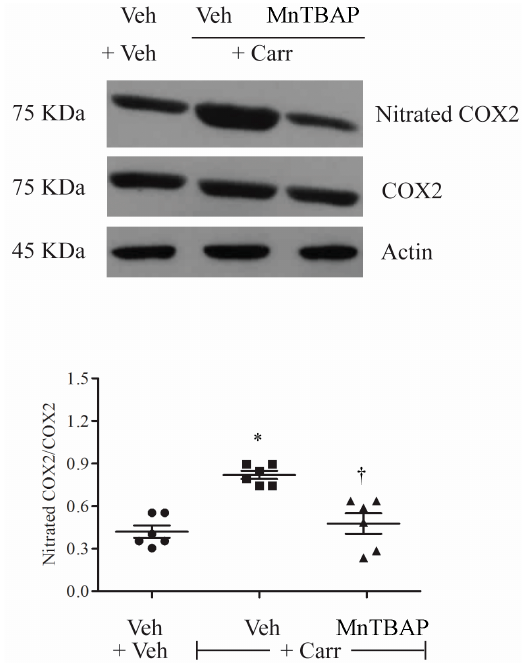
Figure 4. Compared with the vehicle group, animals that received a carrageenan injection showed significant nitration of cyclooxygenase 2 (COX-2). Administration of MnTBAP (10 mg / kg) 15 min before carrageenan partially attenuated COX-2 nitration. No difference for COX-2 or β -actin expression was detected among the lanes in these conditions. Gels are representative of results from six animals, and the histogram represents densitometric analyses of all animals per groups. Results are expressed as mean ± SEM for six rats. * p < 0.001 compared to Veh + Veh; † p < 0.001 compared to Veh + Carr.